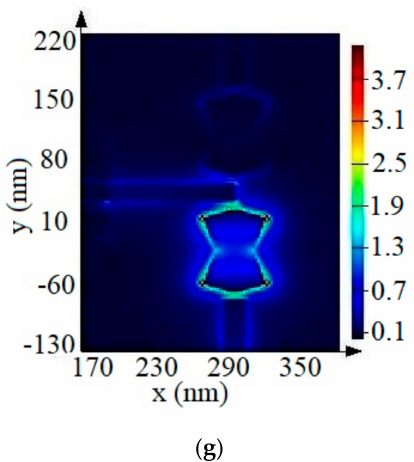
Figure 4. ( a ) 2D top view (side view is the same as Figure 1b) of the MIR two-channel demultiplexer. Transmission spectra of the output ports of the proposed two-channel demultiplexer for the resonators with di ff erent ( b ) lengths (channels 1 and 2 with the lengths of L 1 = 80 nm and L 2 = 100 nm), ( c ) Fermi energies (channels 1 and 2 with the Fermi energies of E f1 = 0.6 eV and E f2 = 0.8 eV), ( d ) widths (channels 1 and 2 with the widths of W 1 = 20 nm and W 2 = 30 nm), and ( e ) angles (channel 1 and 2 with the angles of θ 1 = 40 ◦ and θ 2 = 60 ◦ ). | E | Field profiles of the proposed two-channel demultiplexer for the resonators with di ff erent lengths of L 1 = 80 nm and L 2 = 100 nm in the resonance wavelengths of ( f ) λ = 6.8 µ m and ( g ) λ = 8.05 µ m.